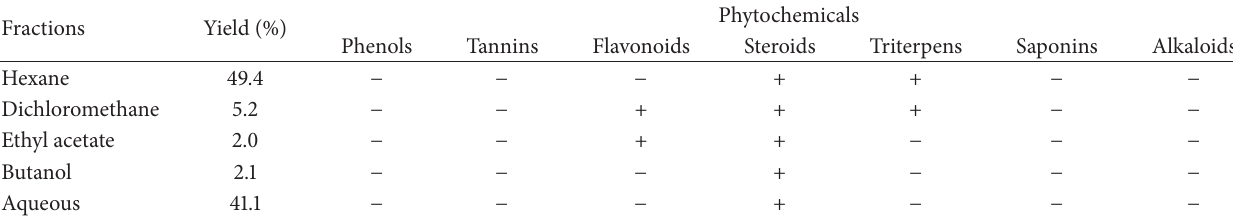
Table 1: Preliminary phytochemical screening of fractions of C. procera